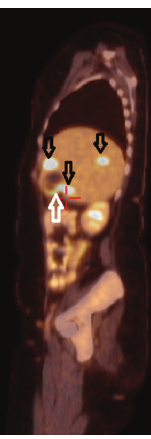
Figure 2: PET-CT showing a hypermetabolic aspect of the uterus (not in this image), gallbladder fundus (white arrow pointing upward), and three liver lesions (black arrows pointing downward), all suspect for neoplastic or inflammatory